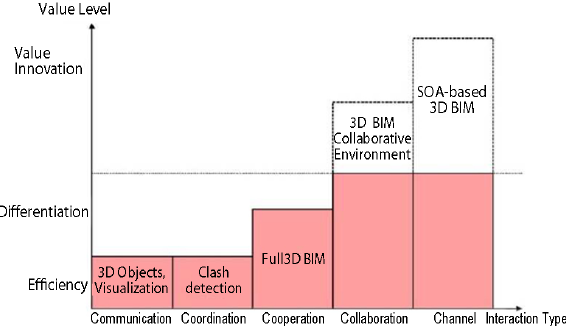
Fig. 1. Interoperability value levels (Grilo, Jardim-Goncalves